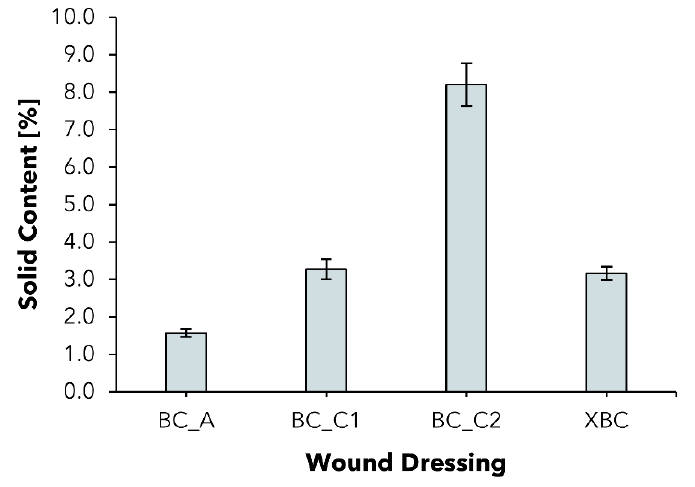
Figure 2. Solid content of wet bacterial cellulose wound dressings (mean ± SD; n = 8). BC_A represents a moist dressing with an SC of 1.57 ± 0.10%, which is in accordance with former works [36]. The value was increased by more than two, resp. five times to 3.27 ± 0.27% for BC_C1 and 8.20 ± 0.57% for BC_C2. The commercial product XBC is comparable to BC_C1 in terms of the SC. Since the dressings tend to reswell to their original water resp. solid content when in contact with excess liquid such as wound exudate, the increased solid content represents the starting point for an improved exudate